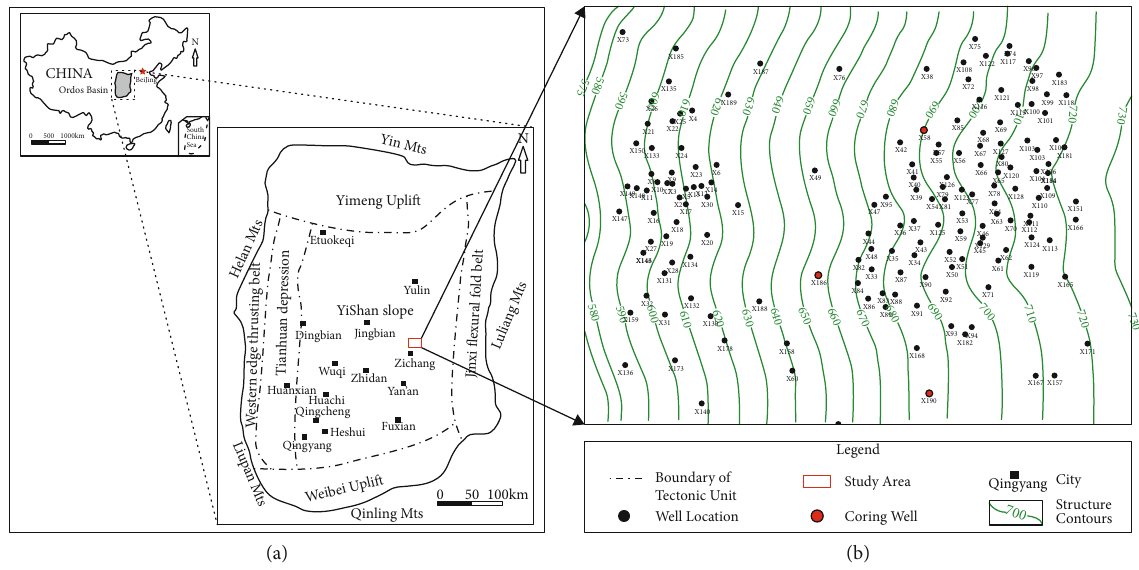
Figure 1: Location of the study area and coring wells. (a) Location of the study area. (b) Location of the coring wells.